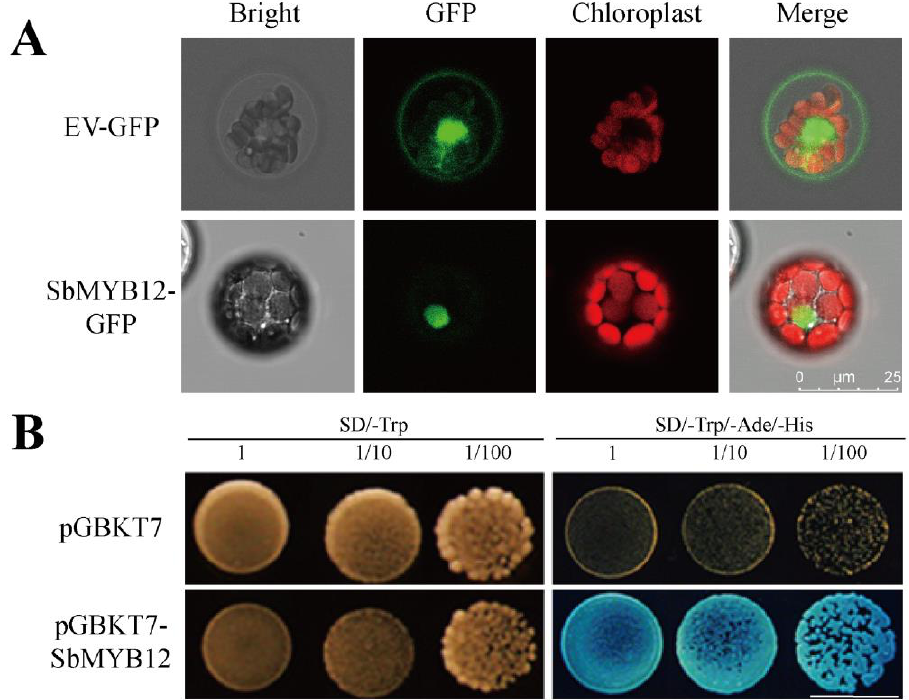
Figure 4. Subcellular localization and transactivation activities of the Sb MYB12 protein. ( A ) Subcellular location of Sb MYB12 in Arabidopsis mesophyll protoplasts. ( B ) Transcriptional activation activity analysis of BD- Sb MYB12 in yeast (Scale bar: 8mm).